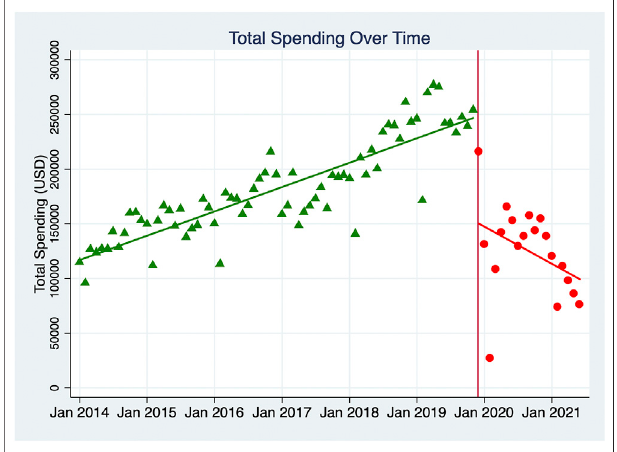
FIGURE 2 | Monthly total spending (USD) of ten NKMDs combined. The monthly spending (USD) for all NKMDs combined over time was demonstrated, from January 2014 to June 2021. The linear trends of spending (USD) in the pre-intervention period and the post-intervention period were labeled with different colors, green-pre-intervention period and red-the post-intervention period.